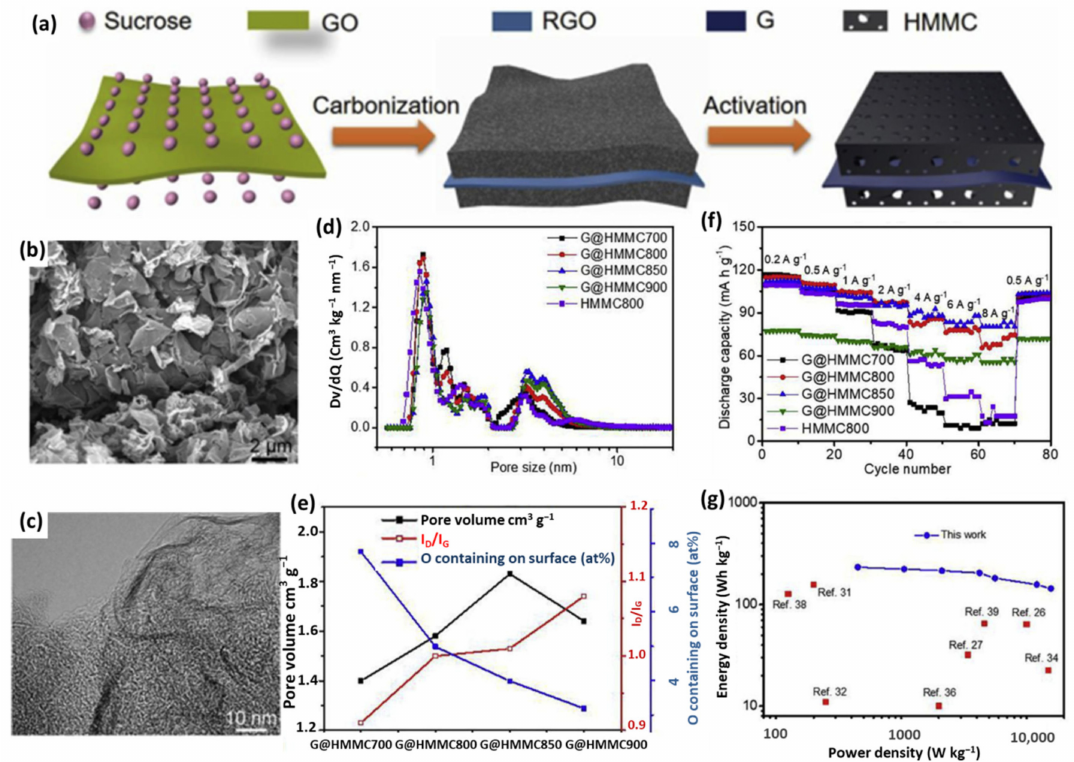
Figure 8. ( a ) Schematic of fabrication process of G@HMMC; ( b ) SEM and ( c ) TEM images of G@HMMC850; ( d ) PSD, ( e ) the pore volume, O contained on surface, and I G /I D values and ( f ) rate performances of G@HMMC materials; ( g ) Ragone plot of G@HMMC-based LIC compared with other works. (Reprinted with permission from Ref. [116]. Copyright 2018